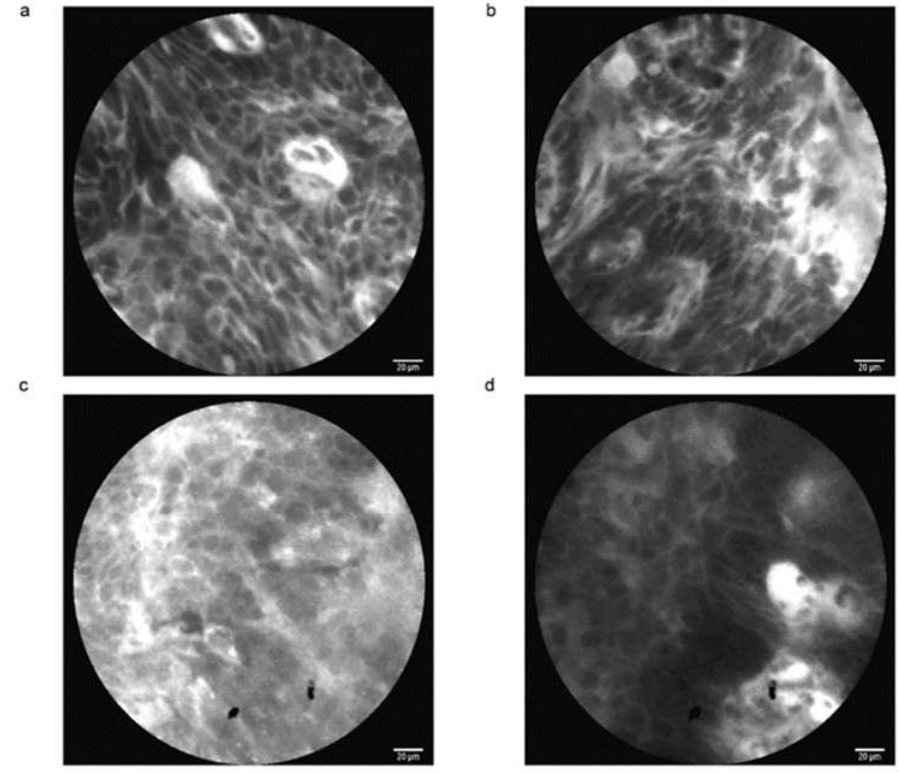
Figure 1. Examples of CLE images in the human esophagus. CLE showed high-grade dysplasia with irregularly thickened epithelial borders and dilated irregular vessels ( a , b ). CLE showed inhomo- geneous squamous epithelium with irregular architecture and unclear cell boundaries in the early esophageal squamous cell neoplasm ( c , d